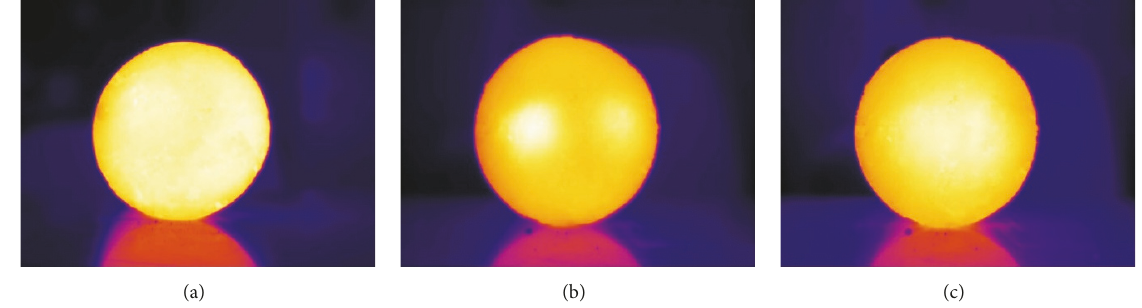
Figure 2: (a) Specimen with defects that are inserted in the depths of 5 and 10 millimeters (heated up using an oven), (b) specimen with defects that are inserted in the depth of 5 and 10 millimeters (heated up using heat blower), image taken 2 minutes into the cooling cycle, and (c) specimen with defects that are inserted in the depth of 5 and 10 millimeters (heated up using heat blower), image taken 20 minutes into the cooling cycle.